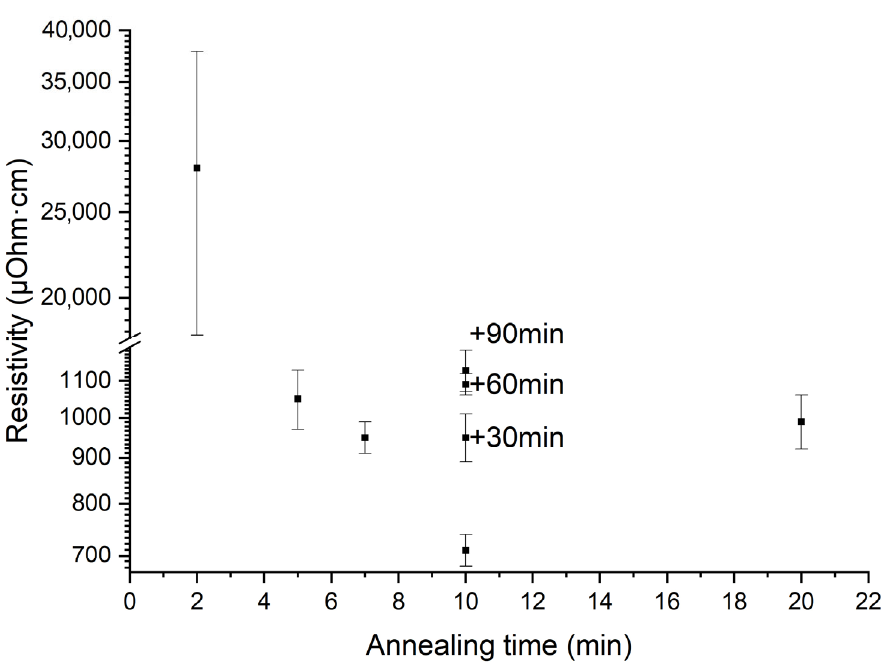
Figure 12. The film resistivity as a function of annealing time of each layer. Samples with additional annealing of the film at 30, 60, and 90 min are shown in at the 10 min annealing time position of each layer during the film preparation. Note: the resistivity scale breaks for a clearer presentation.